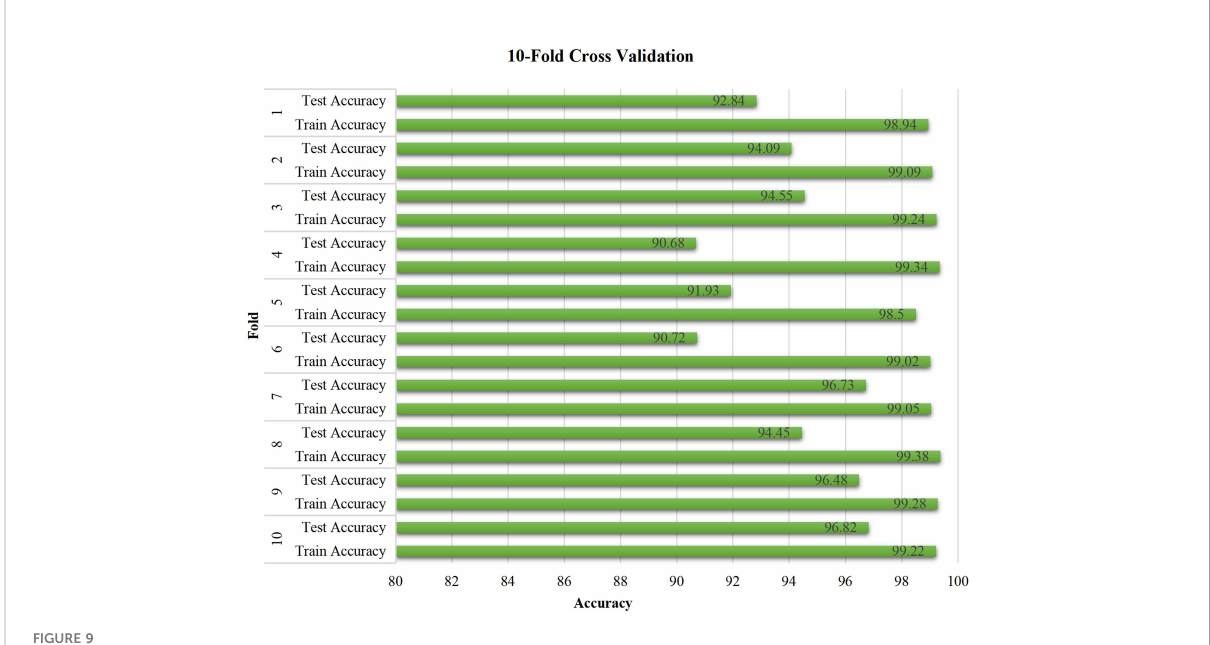
FIGURE 9 Ten-fold cross